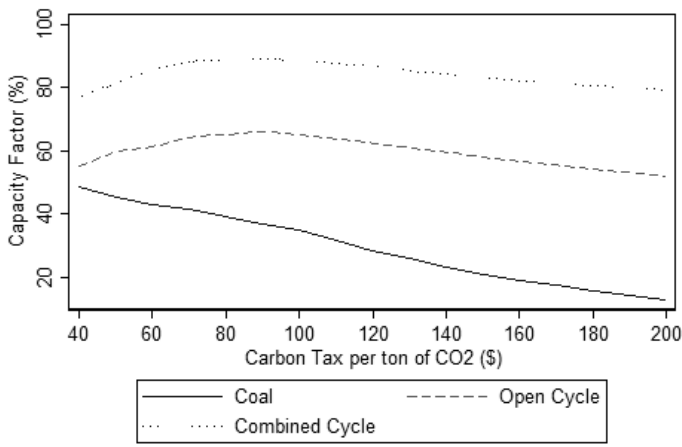
Figure 9. The capacity factors generators with increasing carbon tax.